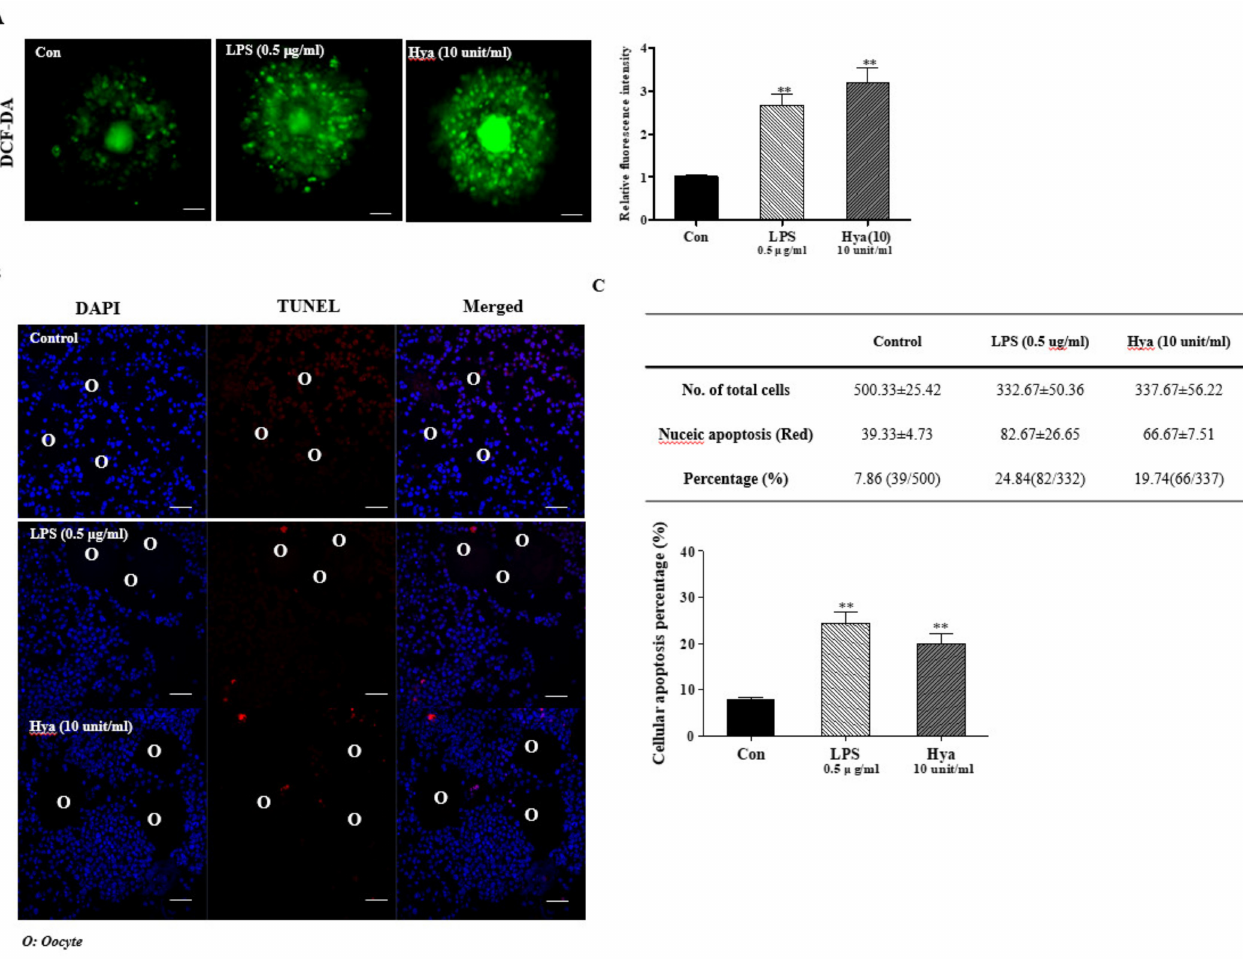
Figure 3. Detection of ROS production and cellular apoptosis by TUNEL staining in ovulated COCs after LPS or Hya treatment. ( A ) Detection of reactive oxygen species (ROS) production in ovulated COCs. COCs were incubated in a culture medium (M16, Sigma) with 1.0 µ g/mL DCF-DA for 15 min (scale bar = 50 µ m). ( B , C ) Detection of apoptosis in CCs of ovulated COCs by TUNEL assay analysis: Hoechst 33342 staining identifying nuclei, TUNEL staining identifying apoptotic cells, and merged photographs of Hoechst 33342- and TUNEL-stained ovulated COCs ( × 20; scale bar = 50 mm). The quantification of fluorescence intensity in DCF-DA- and TUNEL-stained COCs was obtained with Image J software. Data in the bar graph represent the means ± SEM of three independent experiments. **, p < 0.01 compared with the